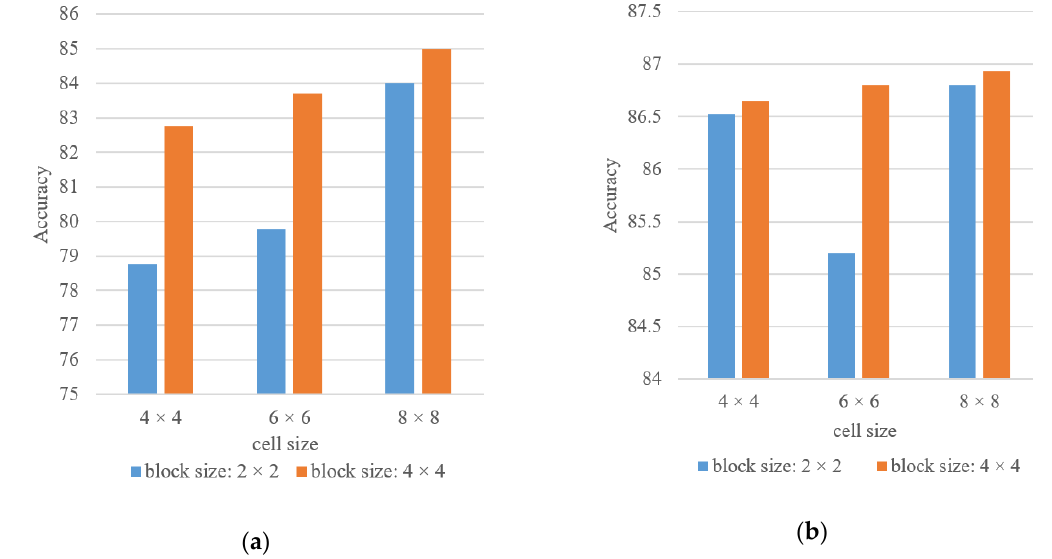
Figure 6. Classification accuracy (%) with varying parameters of histogram of oriented gradients (HOG) for two experimental data: ( a ) The self-built dataset and ( b ) the visible and infrared spectrums (VAIS) dataset.